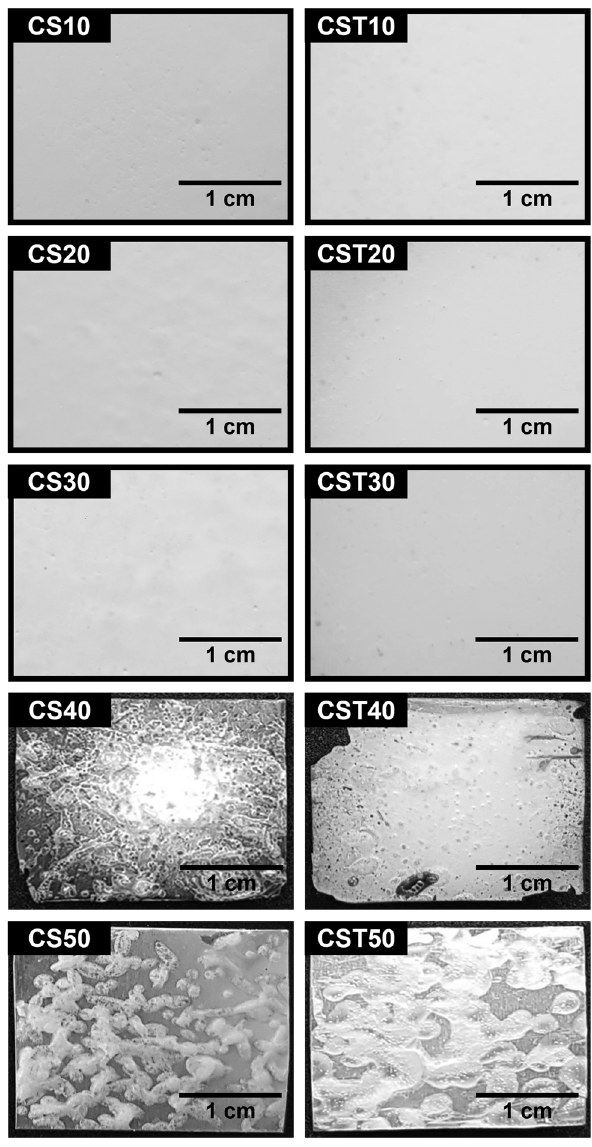
Figure 3: Photographs of the nano fi ber mats prepared in various conditions with and without T80